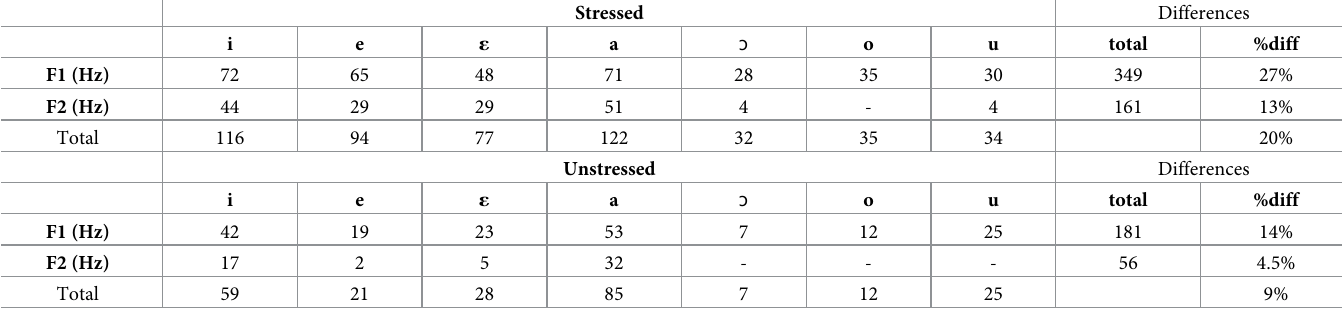
Table 4. Number of significant differences among non-genetically related speakers for stressed and unstressed vowels (p < 0.05/2). Two-tailed test with Bonferroni correction.